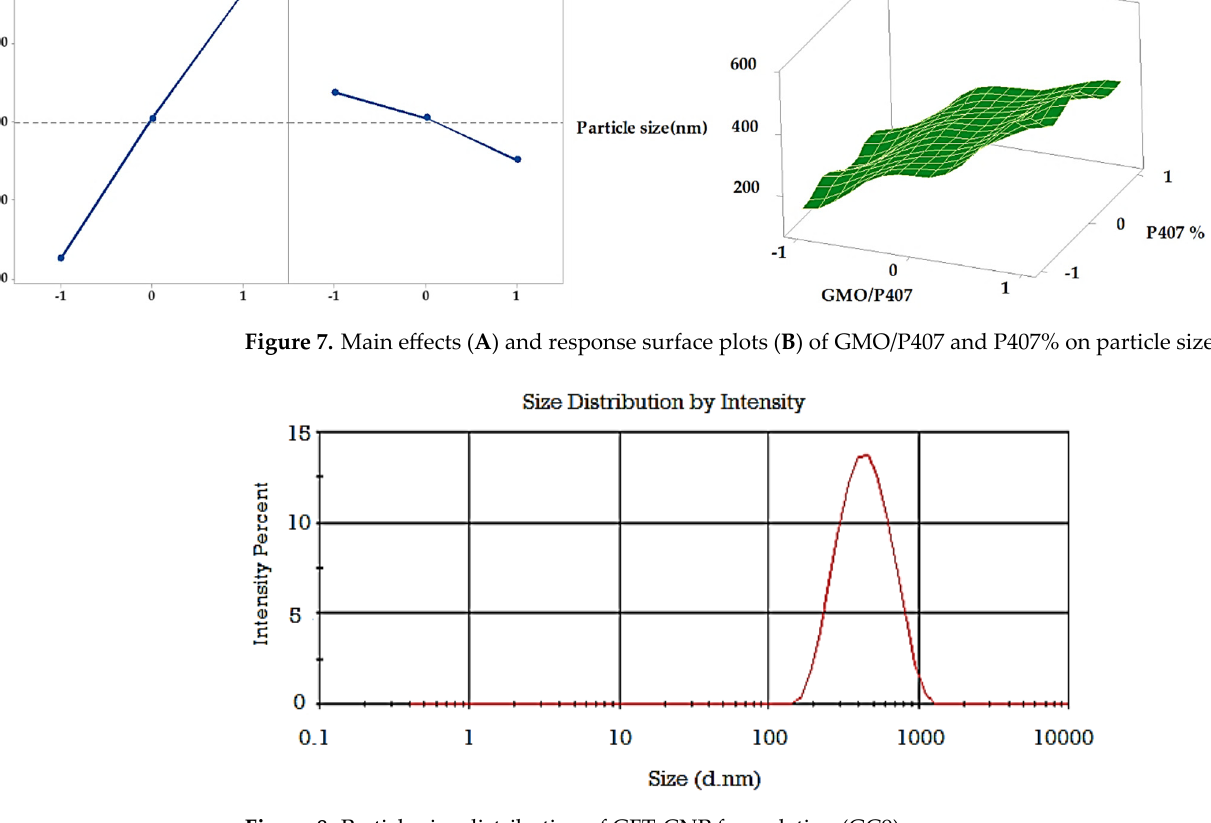
Figure 8. Particle size distribution of GFT-CNP formulation (GC9).